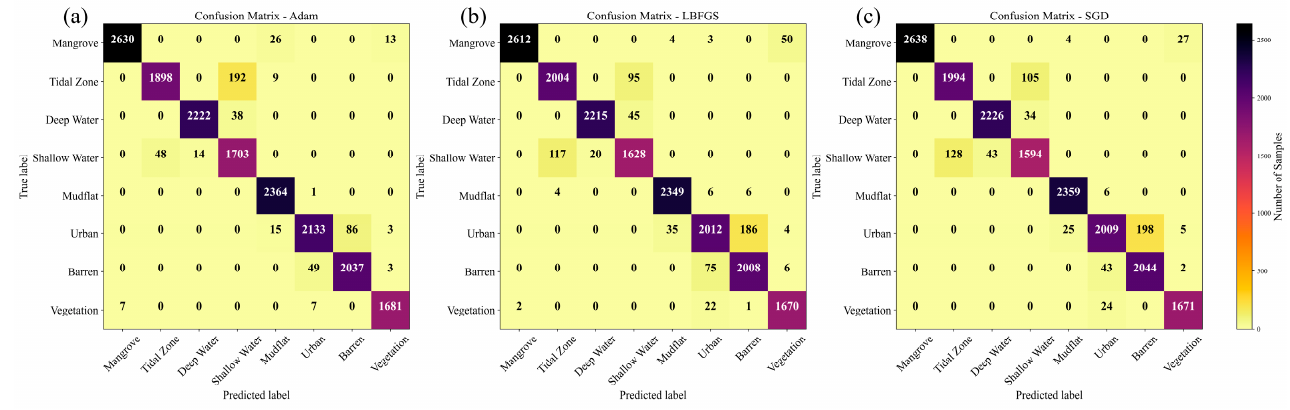
Figure 7. The confusion matrices of the three best ANN models with the learning algorithms of ( a ) Adam, ( b ) LBFGS, and ( c ) SGD. Table 2. Statistical accuracy parameters of the produced mangrove maps using the ANN models with three learning algorithms of Adam, LBFGS, and SGD.